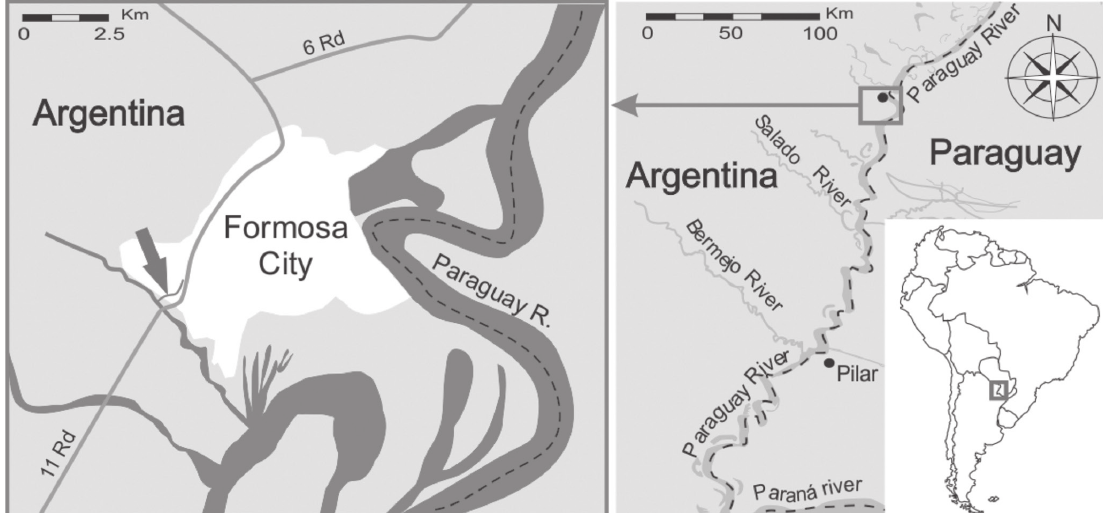
Fig. 1. Map of the study area showing the exact location of the collecting